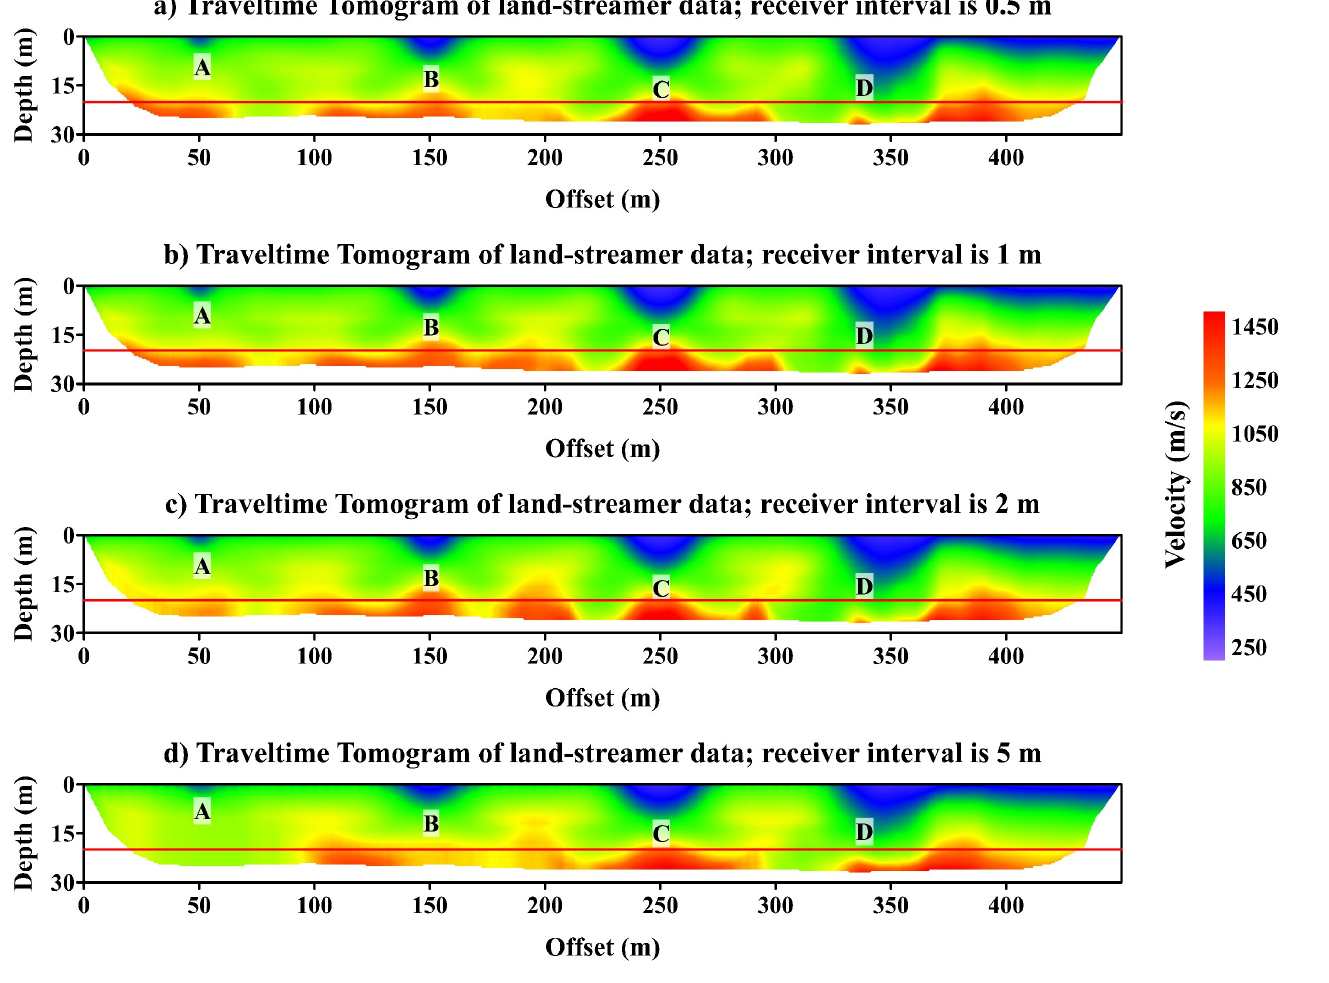
Figure 9. The traveltime tomograms of the land-streamer synthetic example. A, B, C, and D represents the four local anomalies added to the velocity model. The red-horizontal line represents the refractor between the first and second layers. ( a – d ) are the 0.5 m, 1 m, 2 m, and 5 m source and receiver intervals, respectively.